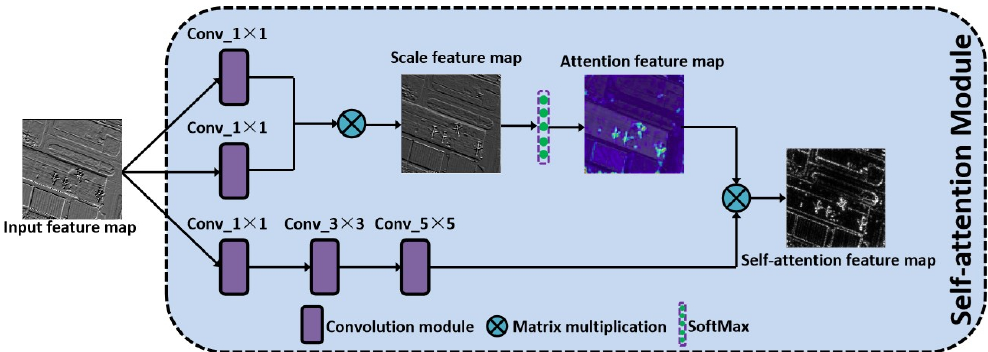
Figure 3. The structure of self-attention mechanism (SAM), including the convolution module, matrix multiplication, and SoftMax